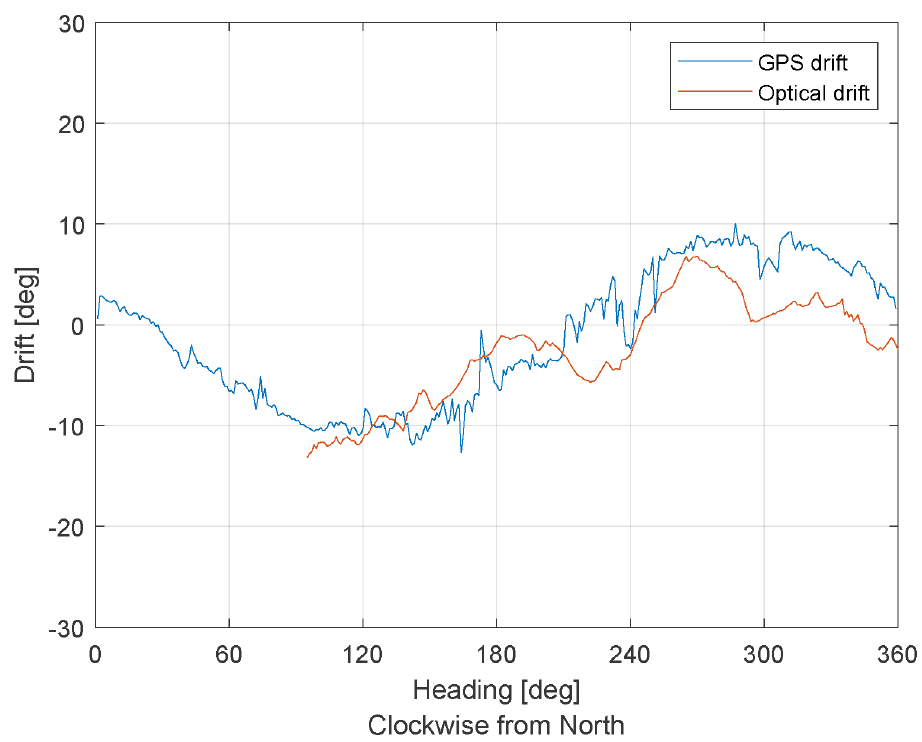
Figure 17. Flight test